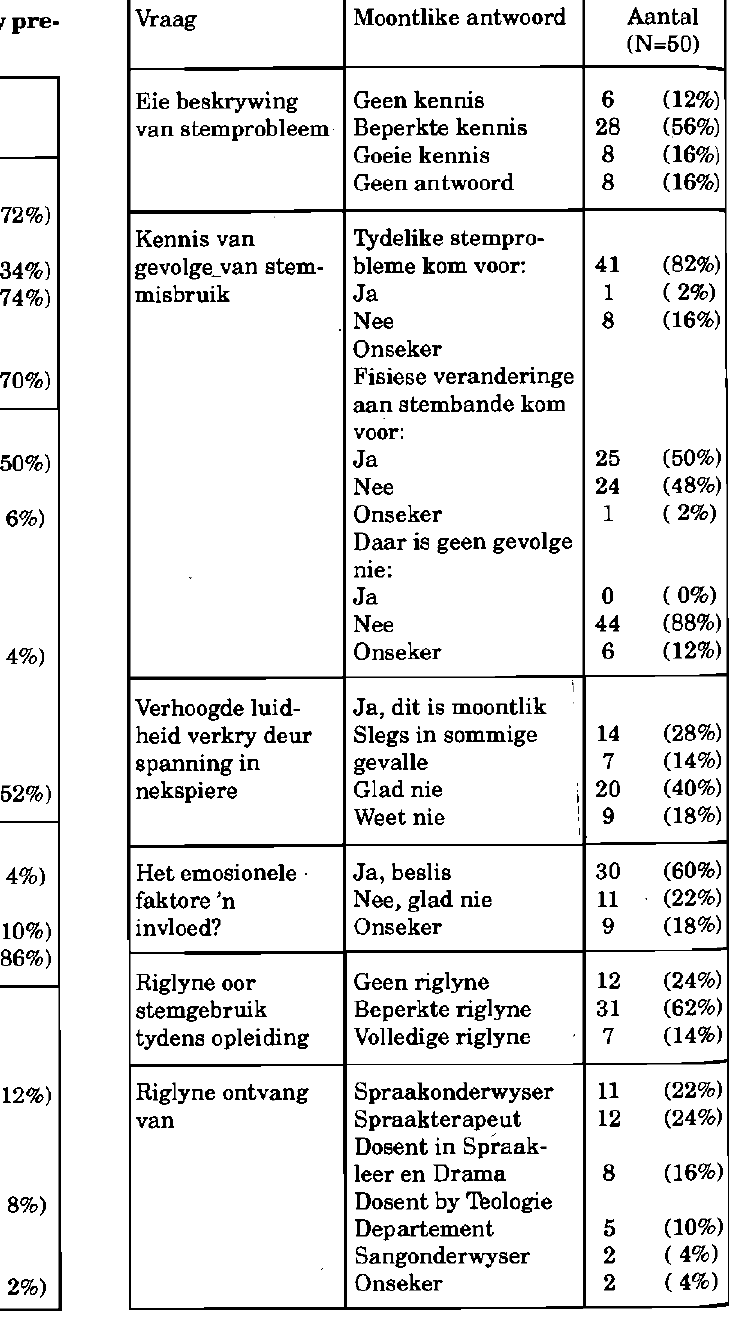
TABEL 6: Kennis van stemprobleme by predikante